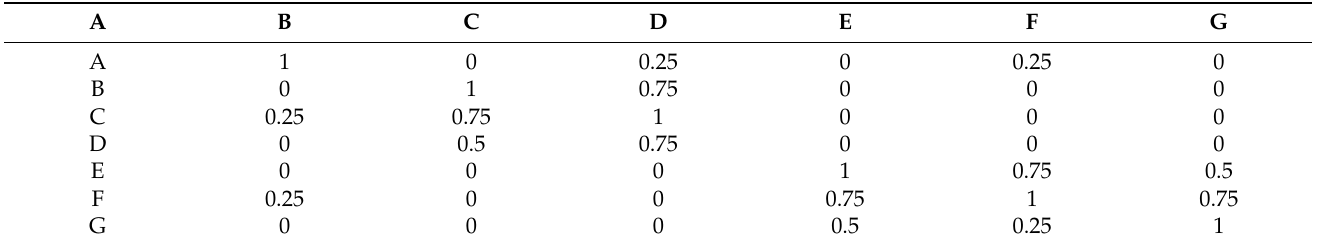
Similarity i p j